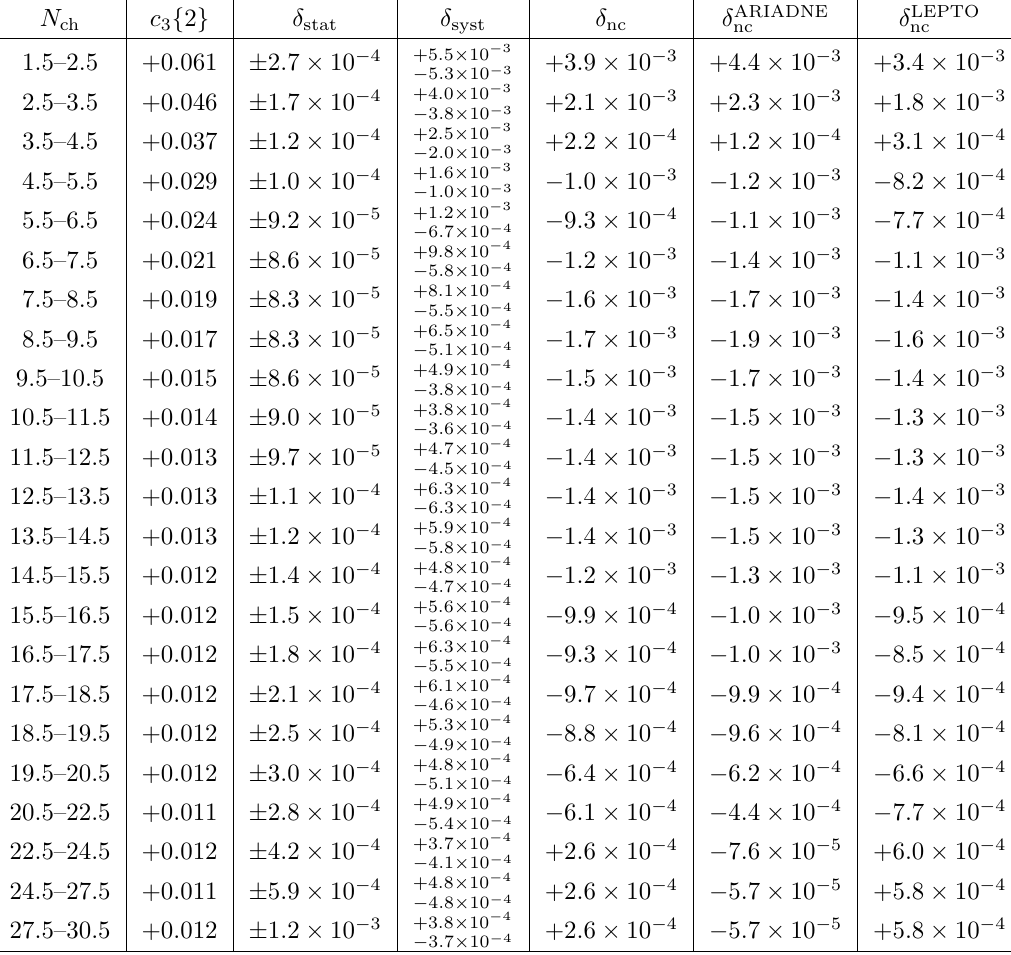
Table 7 . c 3 f 2 g versus N ch from (cid:12)gure 7 (c), p T > 0 : 1 GeV, no j (cid:1) (cid:17) j cut; (cid:14) stat , (cid:14) syst and (cid:14) nc denote the statistical, systematic and Monte Carlo non-closure uncertainties,